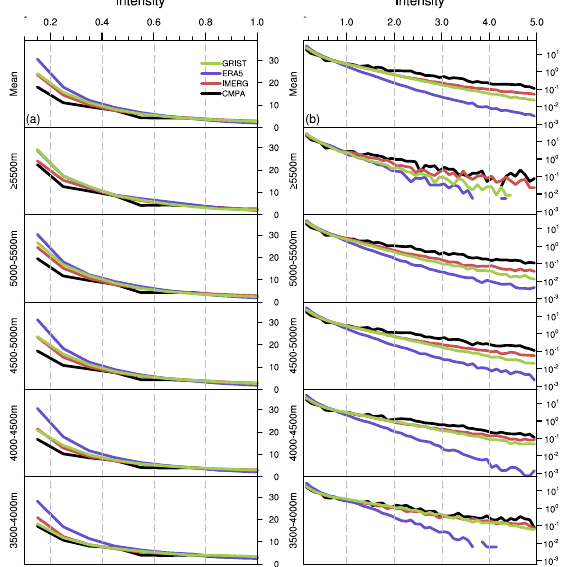
Figure 10. Elevation dependence of frequency–intensity structure in YTRV. ( a ) precipitation fre- quency distribution for weak intensities (0.1–1 mm/h); ( b ) precipitation frequency distribution for all intensities (0.1–5 mm/h) with logarithmic coordinates. Horizontal solid black lines separate different altitude blocks. The altitude of each block increases from bottom to top, with the mean frequency– intensity structure of YTRV displayed in the block at the top. The labels on the right Y -axis represent the frequency (%). The labels on the left Y -axis indicate the altitude intervals represented by each subgraph. The X -axis indicated different rainfall intensities (mm/h). Black stands in for the CMPA dataset, red for IMERG, violet for ERA5, and green for GRIST.